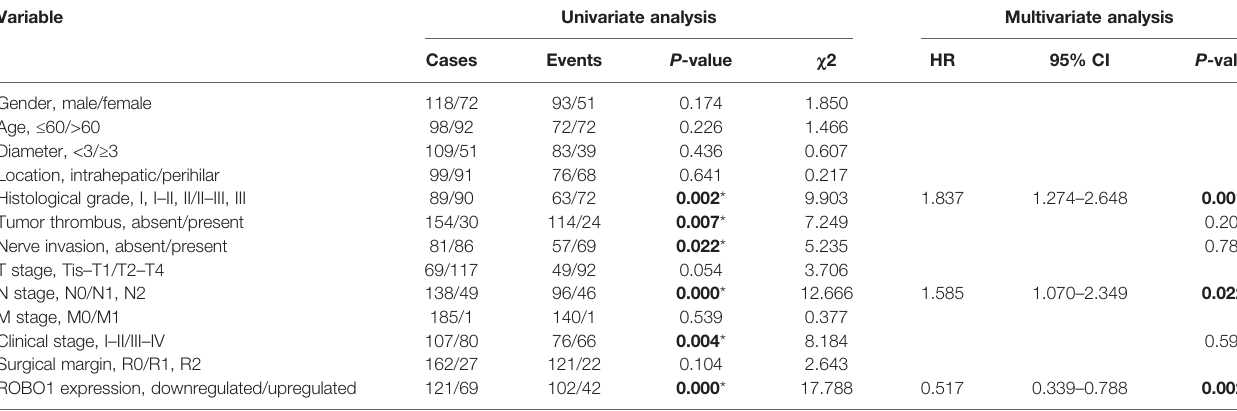
TABLE 1 | Univariate and multivariate analyses of the prognostic factors in Cholangiocarcinoma CCA patients.